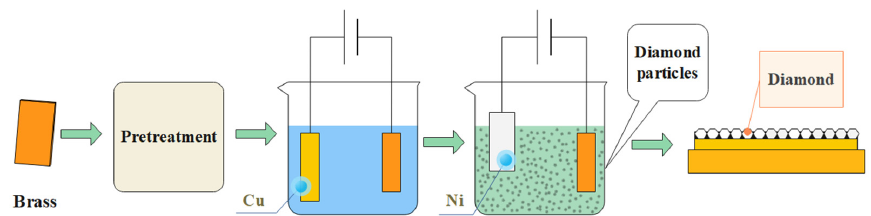
Figure 1. Two stages of the composite electrodeposition.